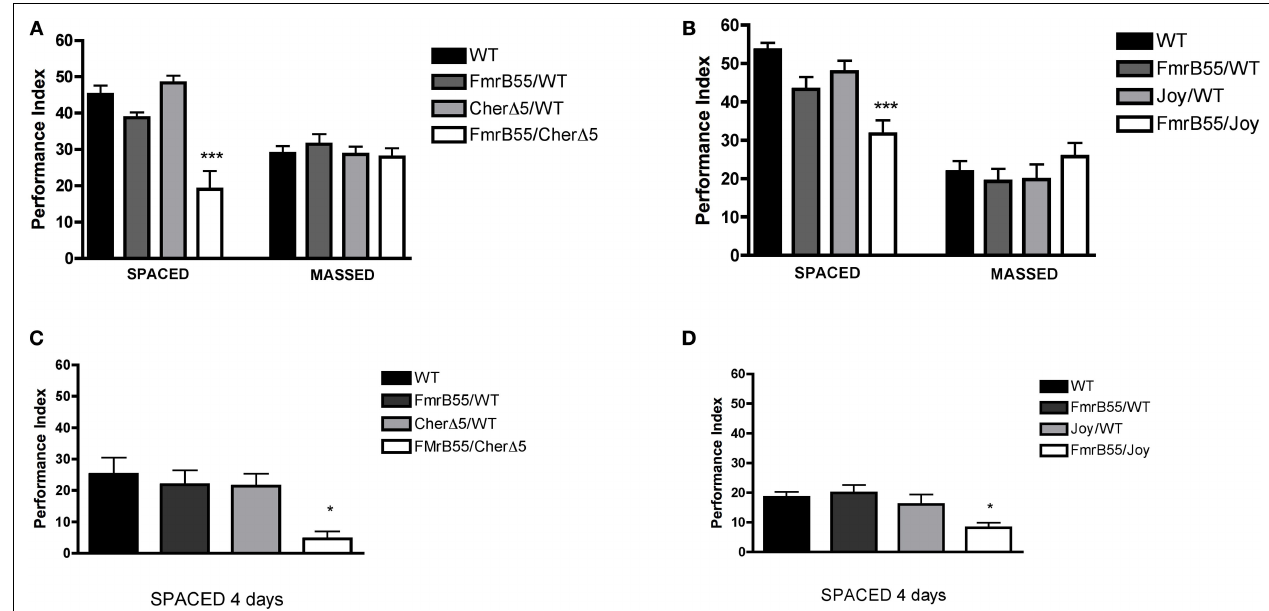
( Figure 1E ). We assessed LTM formation in two different dou- ble heterozygotes, cher Δ 5 / + ; + /Fmr1 B55 and cher Joy / + ; + /Fmr1 B55 . In both cases, 1-day memory after spaced training was signifi cantly reduced ( P < 0.0001 and P < 0.0001, respectively) but that after massed training was not ( P = 0.7478 and P = 0.5314, respectively). In contrast, 1-day memory after both spaced and massed training were normal for each of the single heterozygotes ( cher Δ 5 / + , cher joy / + and Fmr1 B55 / + ) ( Figures 3A,B ). In the double heterozygotes, shock reactivity and olfactory acuity were normal ( Table 1 ), and 4-day memory after spaced training was signifi cantly reduced and near zero ( Figures 3C,D ).